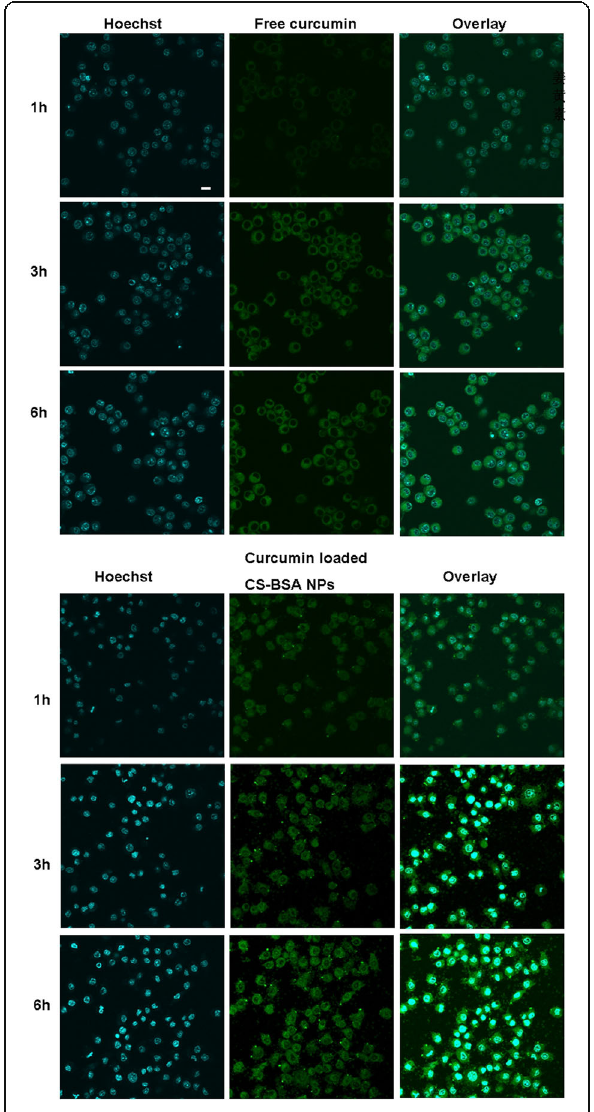
Fig. 4 The uptake of free curcumin and curcumin loaded CS-BSA NPs in RAW 264.7 cells (M1) for 6 h. Curcumin showed green fluorescent color and indicated the intracellular location of free curcumin and curcumin loaded CS-BSA NPs. The nucleus was stained with Hoechst (blue) for 15 min at 37 °C. The scale bar is 50 μ m and applies to all figure parts